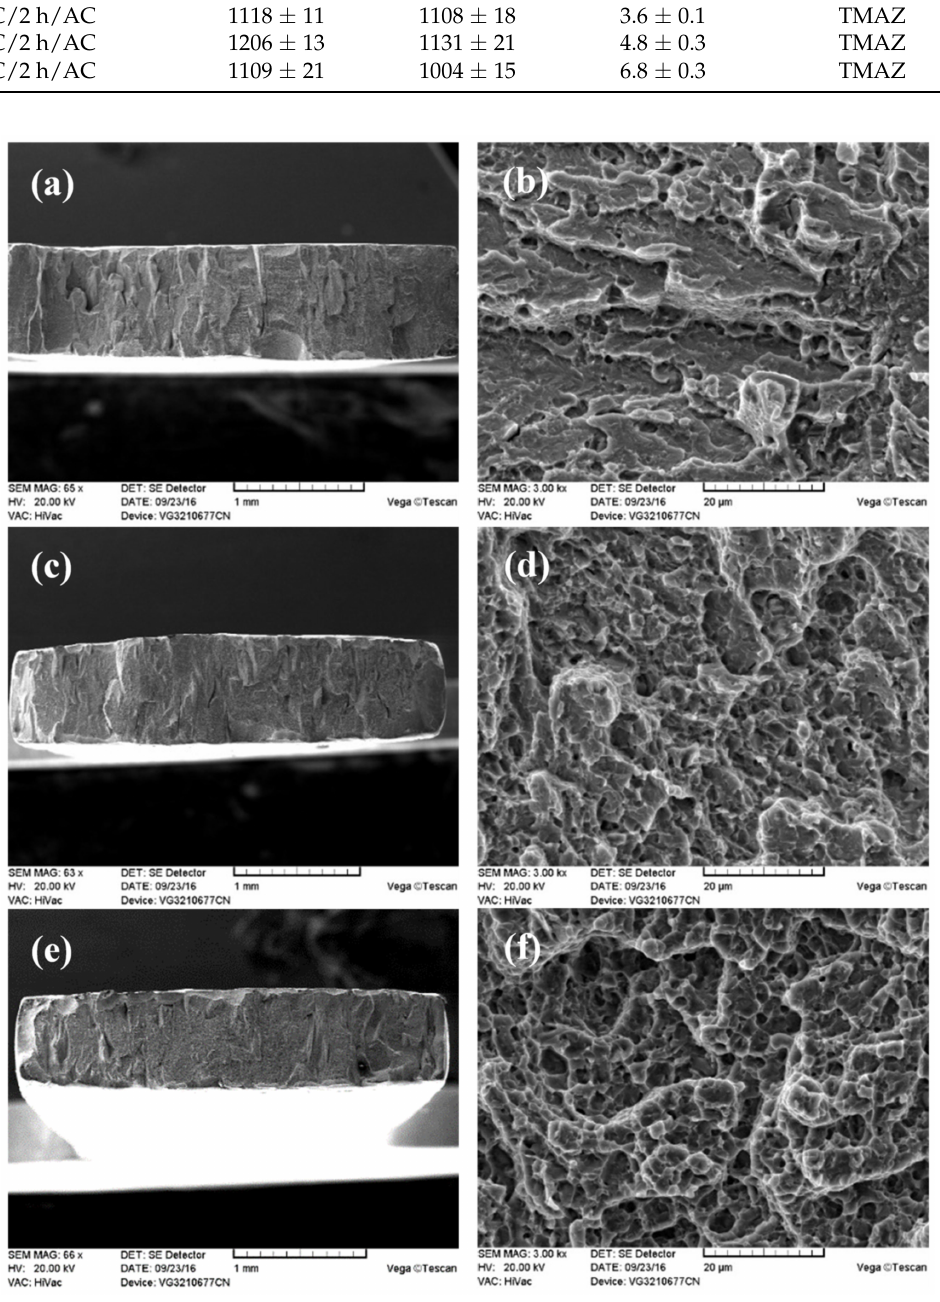
Figure 14. SEM fractography of the aging treated joint after tensile test: ( a ) 760 ◦ C, macro; ( b ) 760 ◦ C, micro; ( c ) 800 ◦ C, macro; ( d ) 800 ◦ C, micro; ( e ) 840 ◦ C, macro; ( f ) 840 ◦ C,